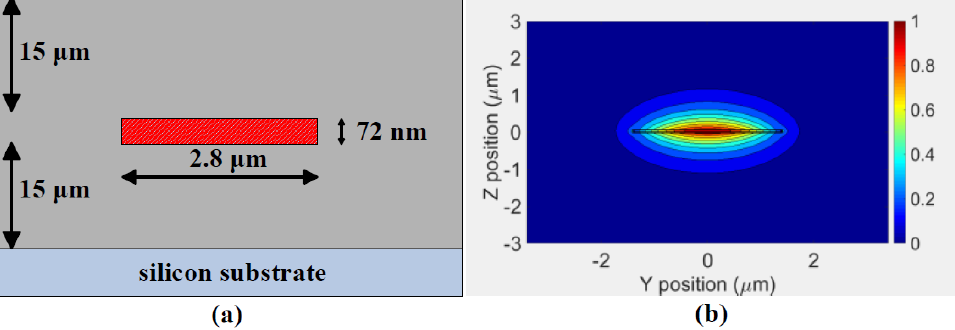
Figure 1. ( a ) Cross-section (not to scale) of the single stripe geometry Si 3 N 4 waveguide, ( b ) Simulated TE mode profile (in linear scale) at 1550 nm wavelength, where the 72 nm thick Si 3 N 4 waveguide is superimposed (drawn to